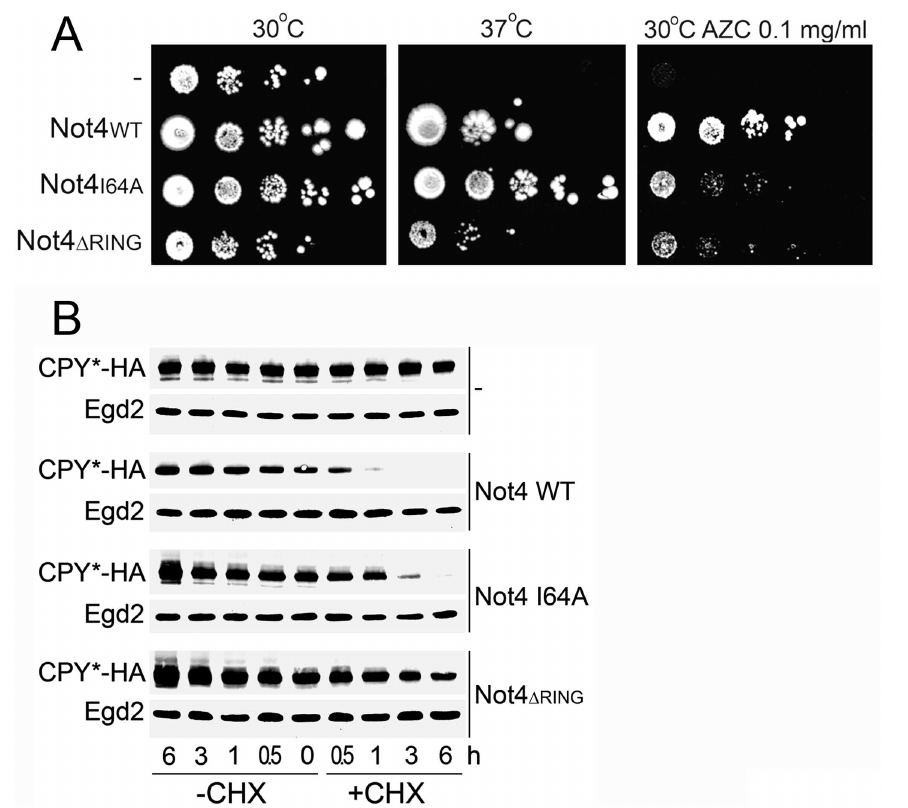
Figure 5. Use of Not4 mutants to characterize the role of Not4 in protein quality control. A. not4 D cells expressing only vector ( 2 ) or vector containing the Not4 derivatives (Not4 WT , Not4 I64A or Not4 D RING ) were analyzed as in Fig. 1 and spotted on – URA plates and left to grow for 13 days at 30 u C or 37 u C. When indicated, plates contained 0.1 mg/ml of AZC. B. Stability of CPY*-HA was analyzed in not4 mutants as in Fig. 4B.